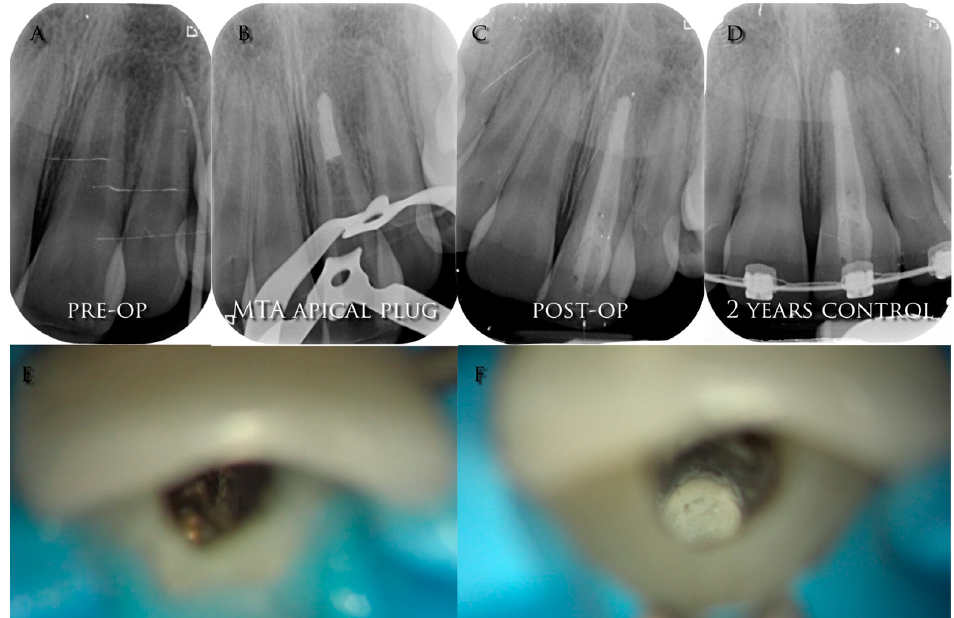
Figure 2. ( A ) Pre-operative radiograph of a young necrotic upper left central incisor with open apex and a periapical lesion; ( B ) radiograph of the MTA apical plug; ( C ) post-operative radiograph; ( D ) 2-years control radiograph; ( E ) intra-operative image of the open apex; ( F ) intra-operative image of the MTA apical plug.